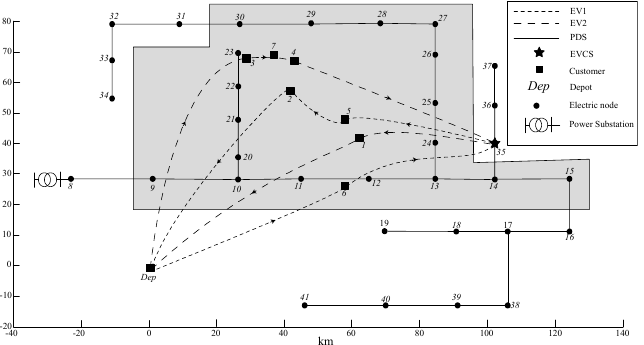
Fig. 11. Pn7k3-DS34N with M =150 and Q =160 km, restricting EVCSs at nodes 9-15 and 20-30